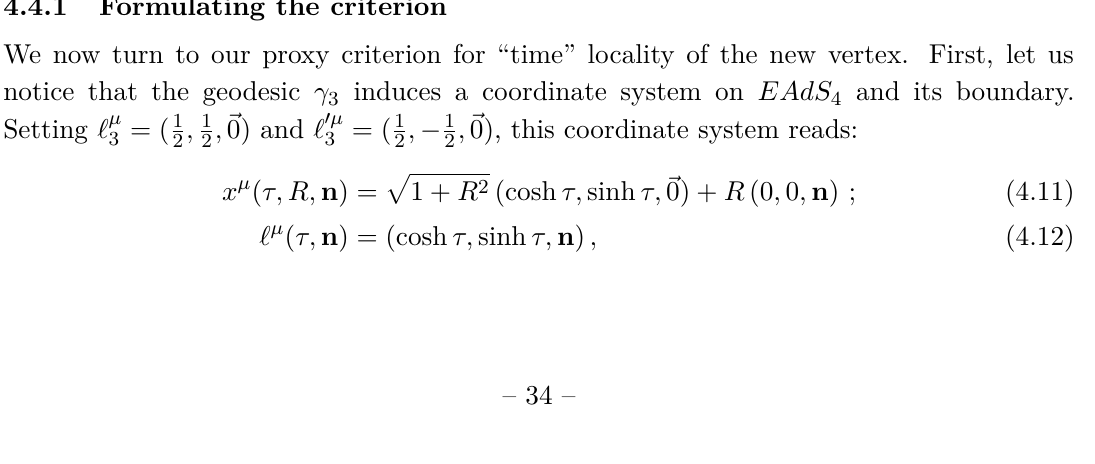
JHEP12(2022)142